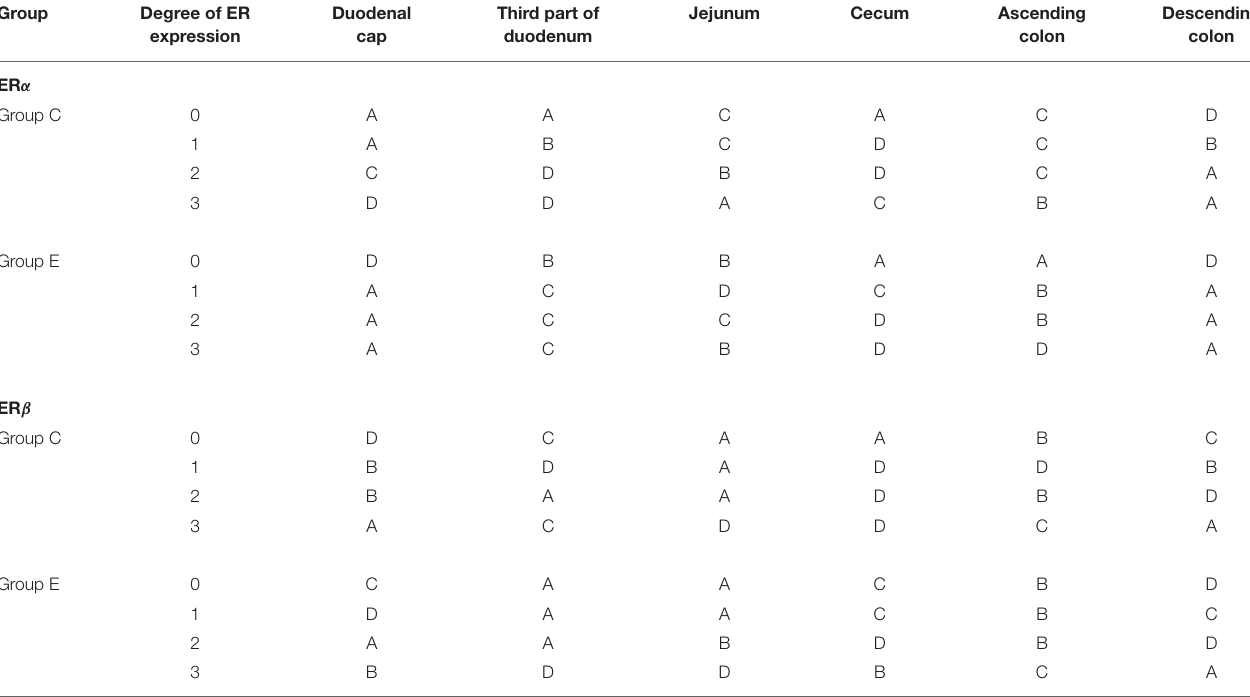
TABLE 2 | ER expression at various absorption levels during the entire experiment in the analyzed segments of the gastrointestinal tract in pre-pubertal gilts. Group Degree of ER Duodenal Third part of Jejunum Cecum Ascending expression cap duodenum